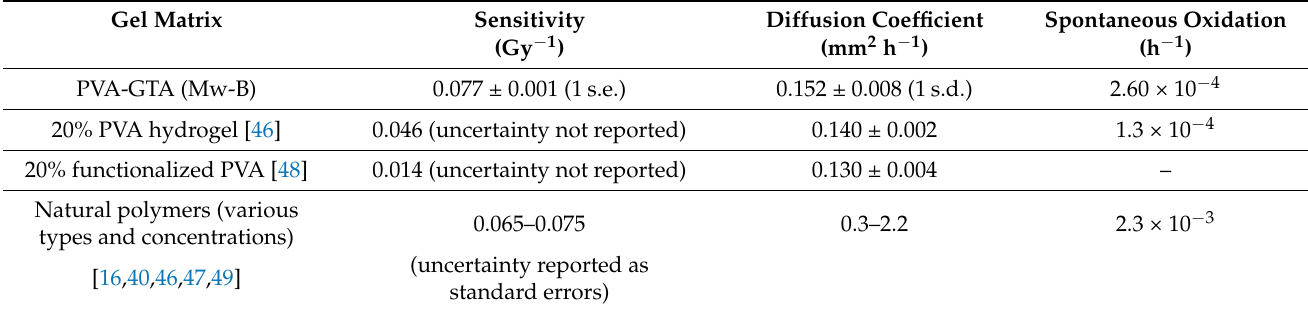
Figure 5. Spontaneous oxidation rate of various PVA and Mowiol gels. Adapted from [26]. Table 3. Comparison with other gel types and